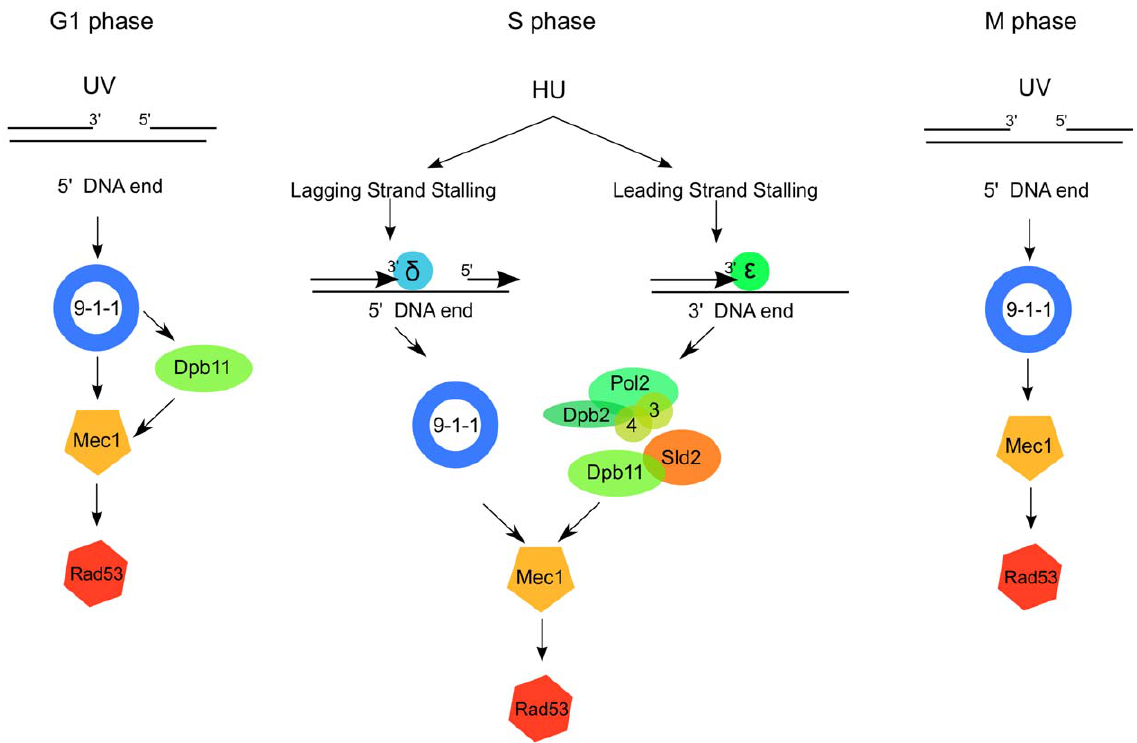
Figure 6. A model for 9-1-1 and Dpb11 function in Mec1 activation. After UV irradiation in G1, Mec1 is activated by the 9-1-1 complex both directly and through the Dpb11 C-terminus (right); in M phase Mec1 activation is achieved mainly through the 9-1-1 complex, independently of Dpb11 (left). In S phase Dpb11 and the 9-1-1 complex signal replication stress to Mec1 independently from each other, likely because the detection of replication stress occurs independently on the leading and lagging strands. 9-1-1 complex could signal replication stress on the lagging strand, where the 5 9 ends necessary for its loading are generated as the result of discontinuous replication. Dpb11, instead, could signal replication stress on the leading strand together with the interacting Pol e